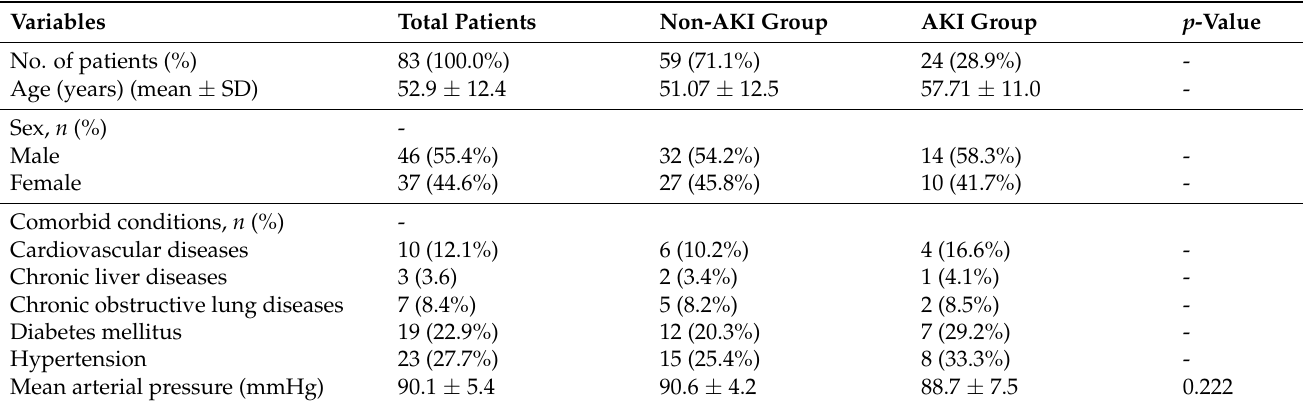
Table 3. Demographic and clinical characteristics of COVID-19 patients on